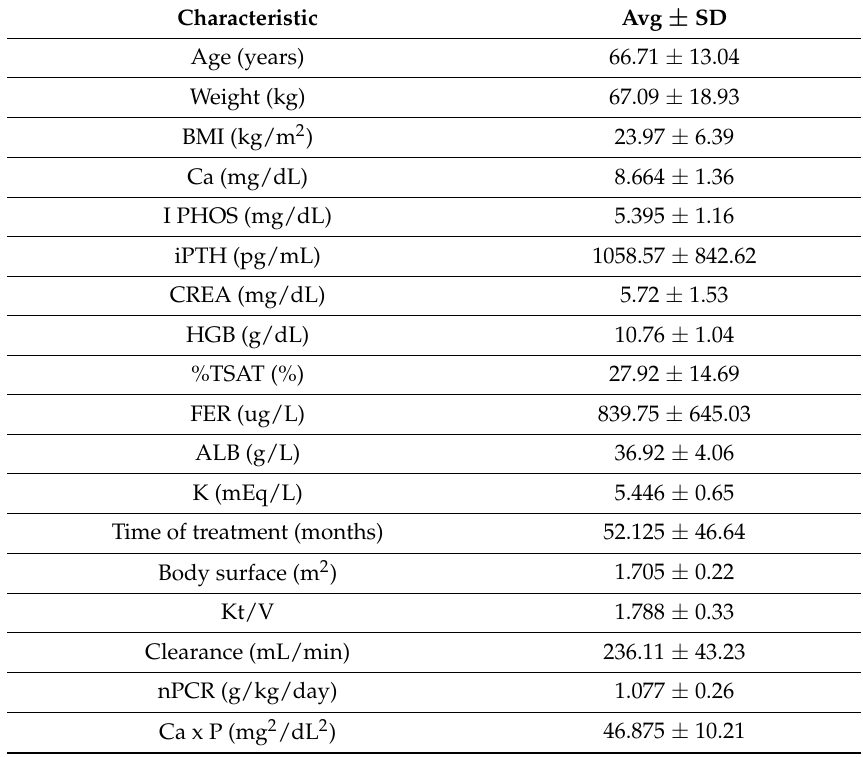
Table 5. The first test group includes patients suffering from chronic kidney disease